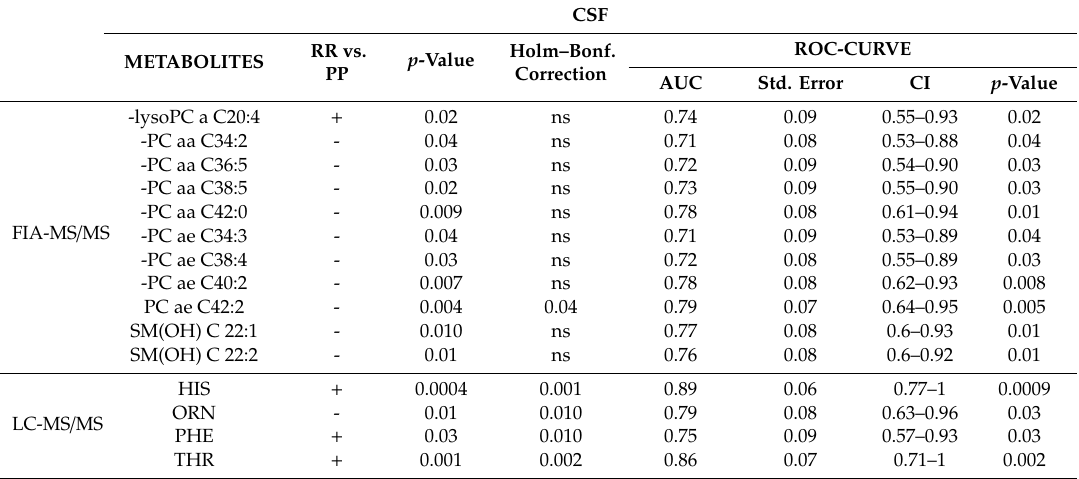
Figure 3. CSF Biomarkers evaluation. Roc curves of the most important metabolites resulting from the multivariate analysis of the CSF matrix, generated with FIA-MS/MS and LC-MS/MS respectively. Table 3. Trend, univariate analysis, and ROC curve analysis of the discriminant metabolites in CSF